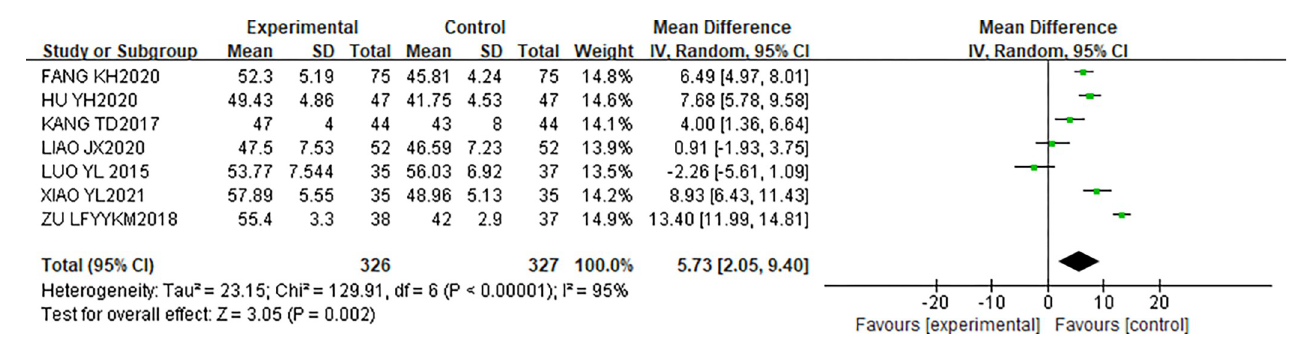
Fig 4. Influence of CR on LVEF of patients.